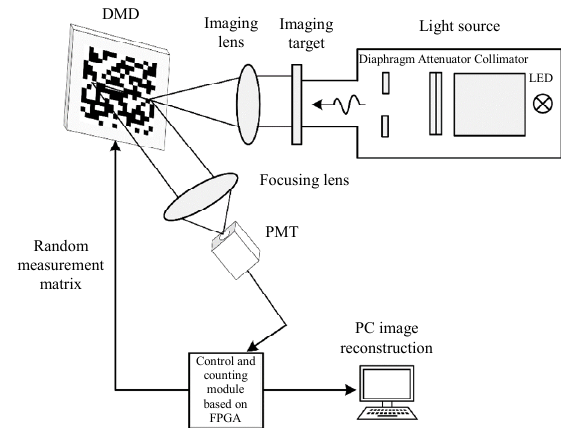
Fig. 1 Schematic diagram of a single photon compressive imaging system, including a parallel single photon source (it consists of light emitting diode (LED) lamp, collimator, attenuator, and diaphragm), imaging target, imaging lens, DMD, focusing lens, and